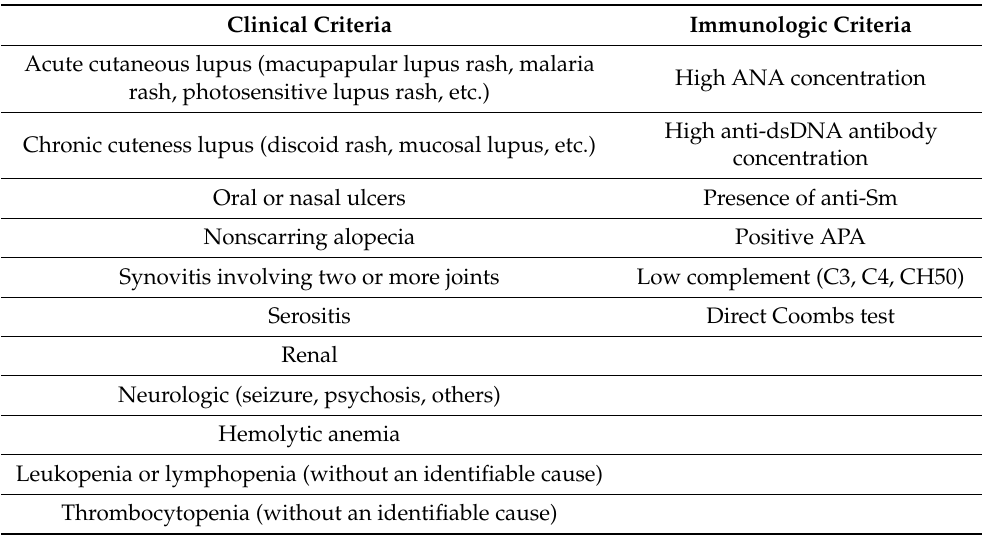
Leukopenia or lymphopenia (without an identifiable